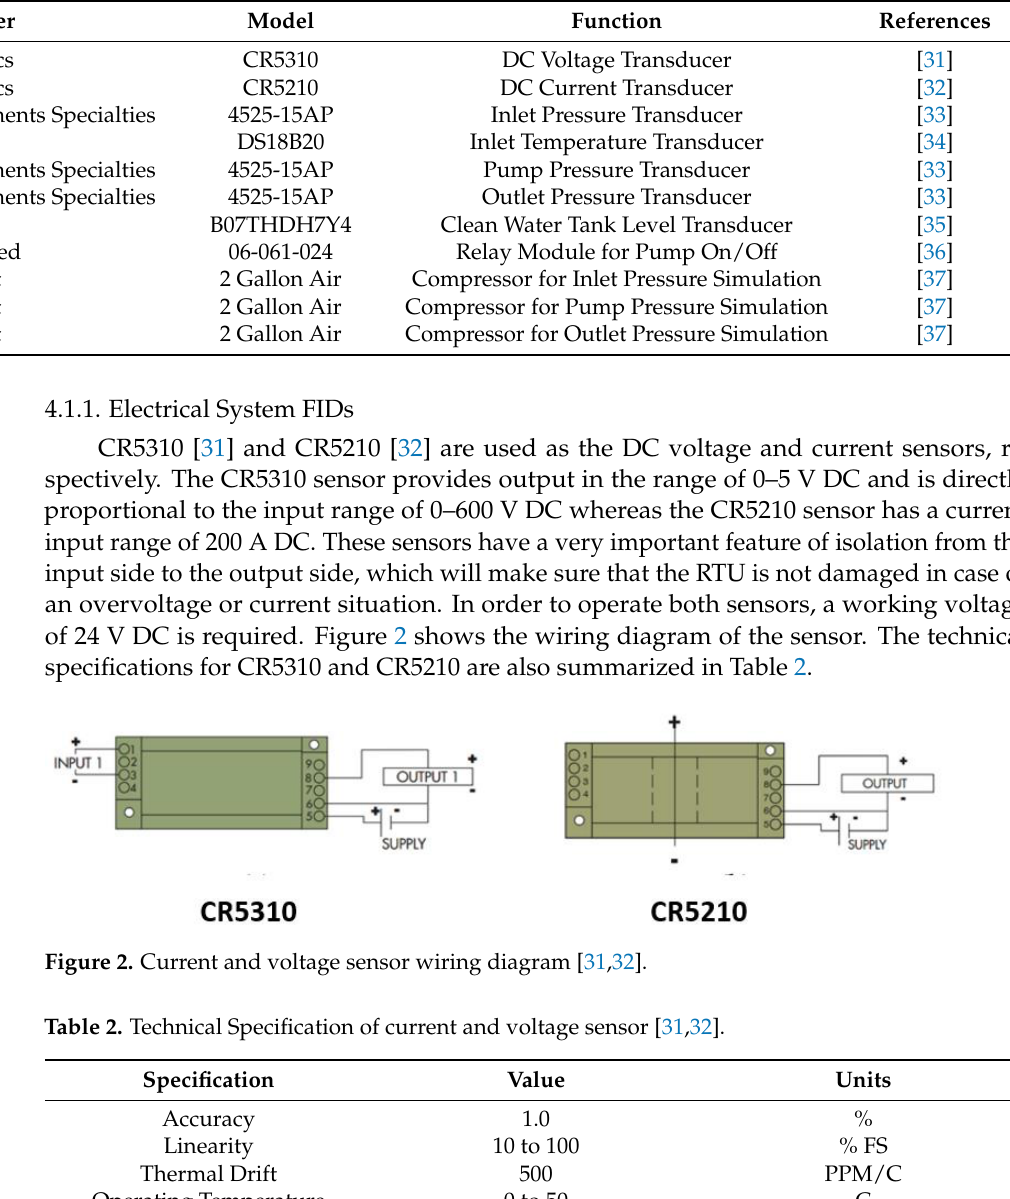
Table 1. Sensor manufacturer, models, and function.